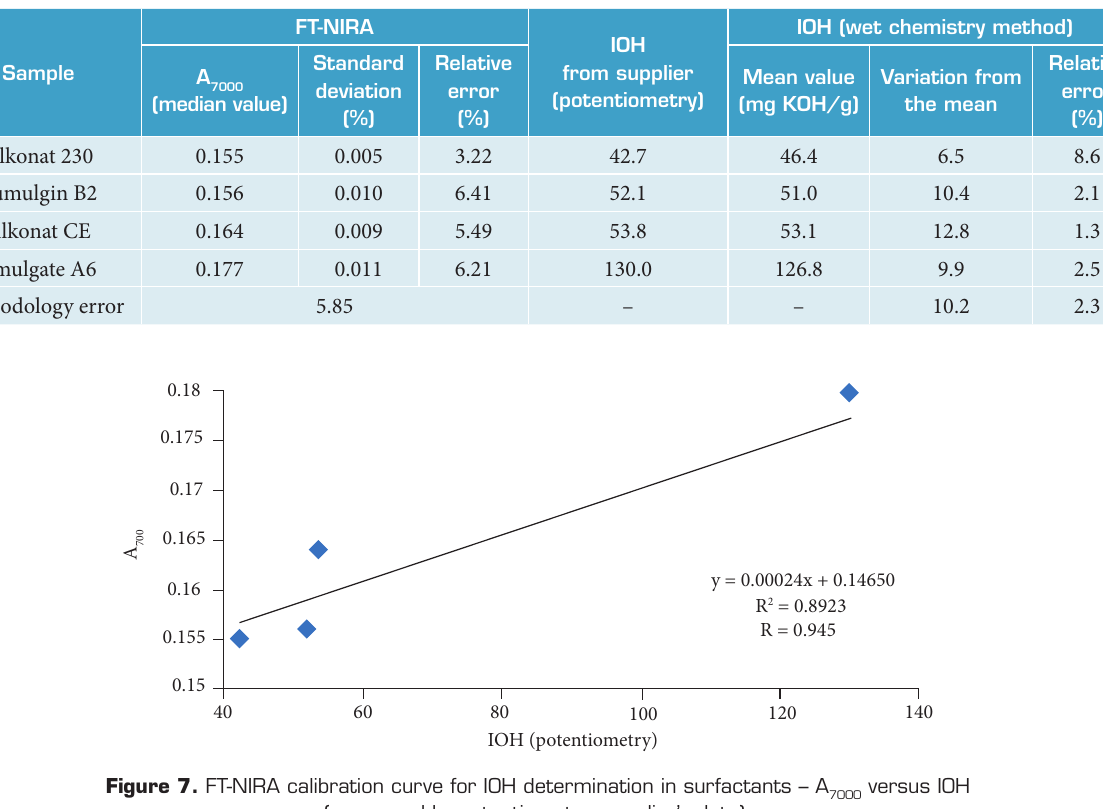
Figure 7. FT-NIRA calibration curve for IOH determination in surfactants – A (measured by potentiometry, supplier’s data).